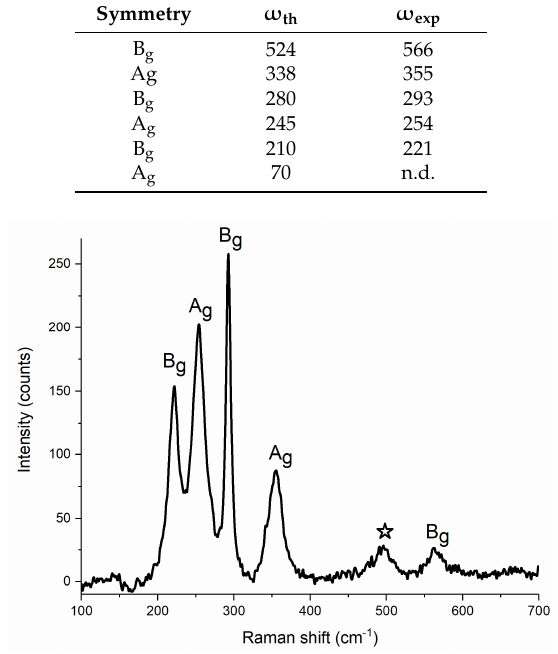
Figure 2. Raman spectrum of powder CuF 2 at ambient condition. Table 1. Comparison of calculated ( ω th ) and experimental ( ω exp ) Γ -point Raman frequencies (in cm − 1 ) of the rutile-type P2 1 / c structure of CuF 2 at ambient pressure. No scaling was applied to the calculated frequencies.